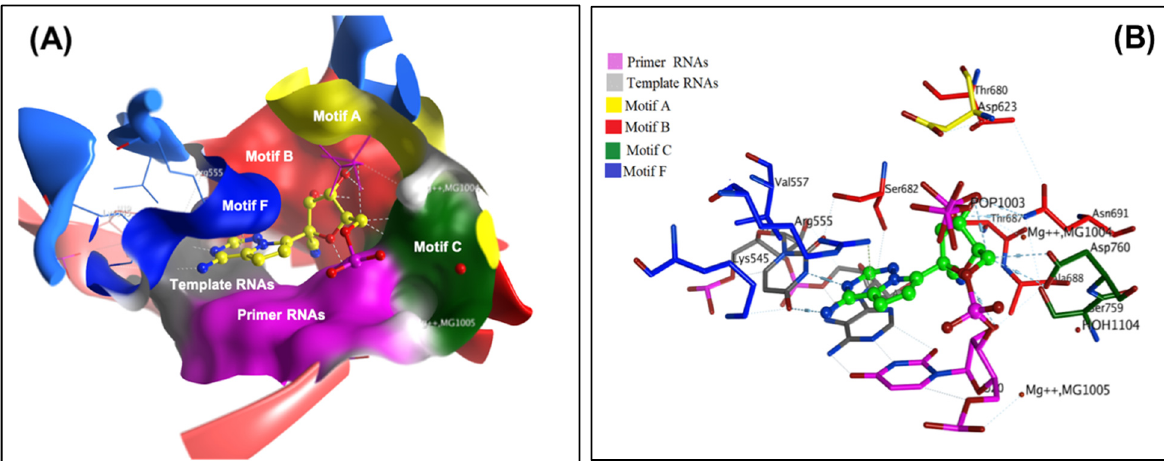
Figure 2. The SARS-CoV-2 RdRp binding site. ( A ) SARS-CoV-2 motifs are depicted as surfaces and color-coded as: motif A (yellow), motif B (red), motif C (green), and motif F (blue) as well as the template (grey)-primer (pink) RNAs. ( B ) The main residues in the binding site are shown in the same color as its motifs and RNAs. The pictures of binding site are generated using the MOE program.